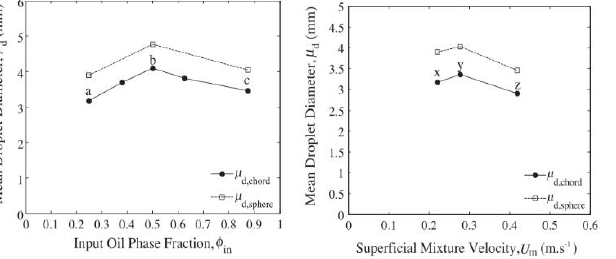
Figure 6. The variation of mean droplet diameter with input oil phase fraction and superficial mixing velocity; The μ d,chord represents the mean diameter of an irregular droplet; The μ d,sphere represents the mean diameter of a sphere droplet [36].